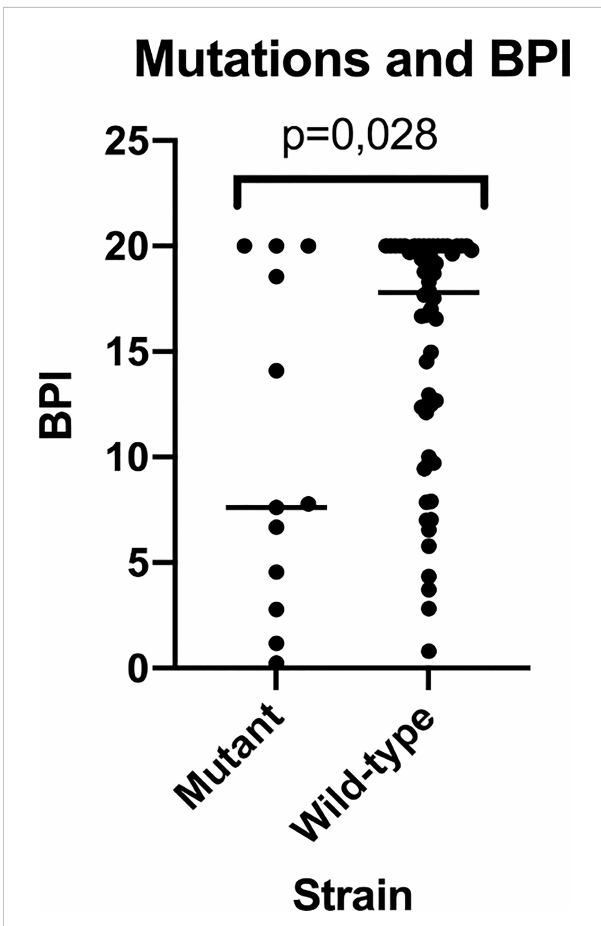
FIGURE 4 BPI of mutant vs wild-type strains for mucA gene. This fi gure shows how mutant strains present a reduced BPI when compared to wild- type strains being this last population much more heterogeneous in BPI testing results.